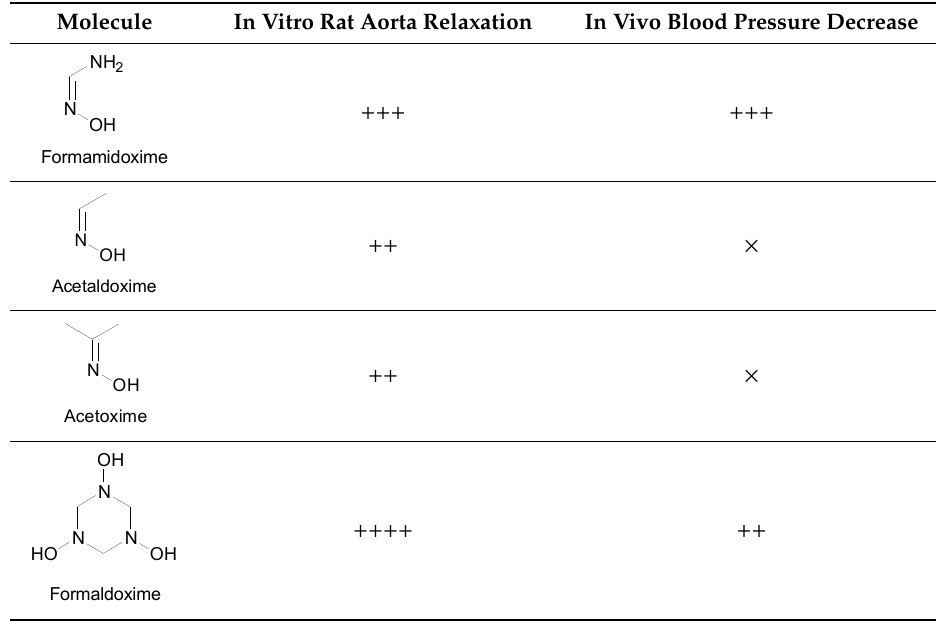
Table 6. Comparison of some studied amidoximes and oximes for their aorta relaxation and pressure decrease abilities.